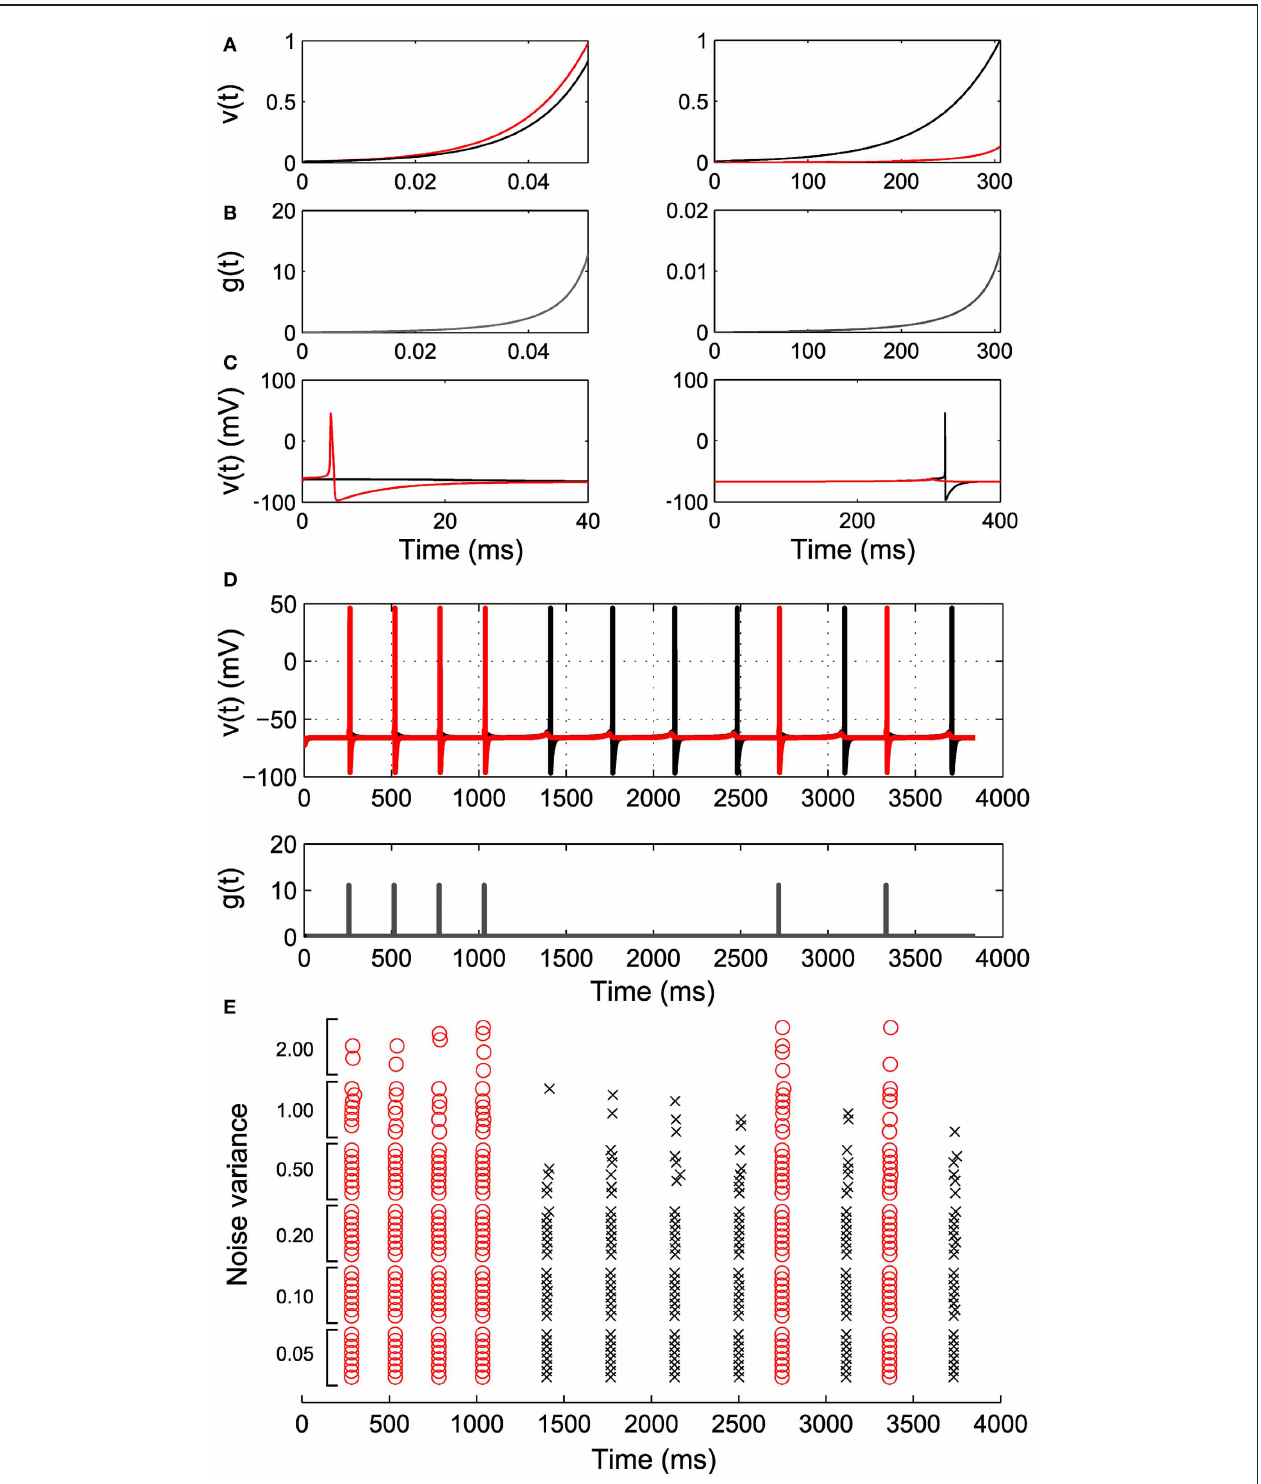
FIGURE 4 | Simulation of Hodgkin–Huxley-type neurons. Two integrate and fire neurons are fit to the HH neurons and control inputs are derived according to our algorithm. (A) The response of the integrate and fire neurons to the derived control inputs in (B) . The red trace corresponds to cell with larger channel conductance. (C) The response of the original HH